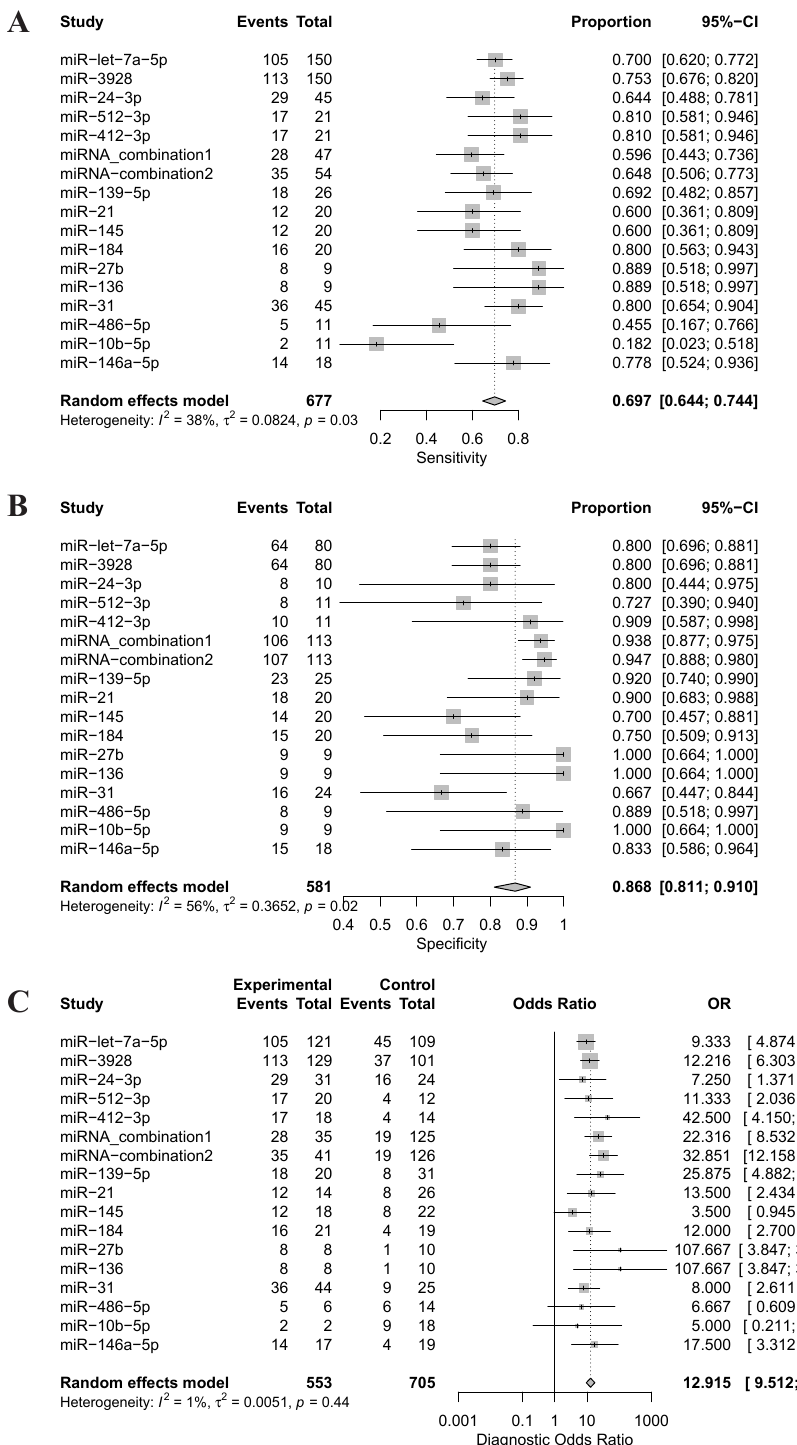
Figure 3. ( A ) Forest plot of the sensitivity of salivary miRNAs for distinguishing head and neck squamous cell cancer patients from healthy controls; ( B ) Forest plot of the specificity of salivary miRNAs for distinguishing head and neck squamous cell cancer patients from healthy controls; ( C ) Forest plot of diagnostic odds ratio of salivary miRNAs for distinguishing head and neck squamous cell cancer patients from healthy controls. miRNA-combination1 includes miRNA-9, -127, -134, -191, -222 and -455; miRNA-combiation2 includes miRNA-9, -134, -210, -455, and -196b; CI, Confidential interval; OR, odds